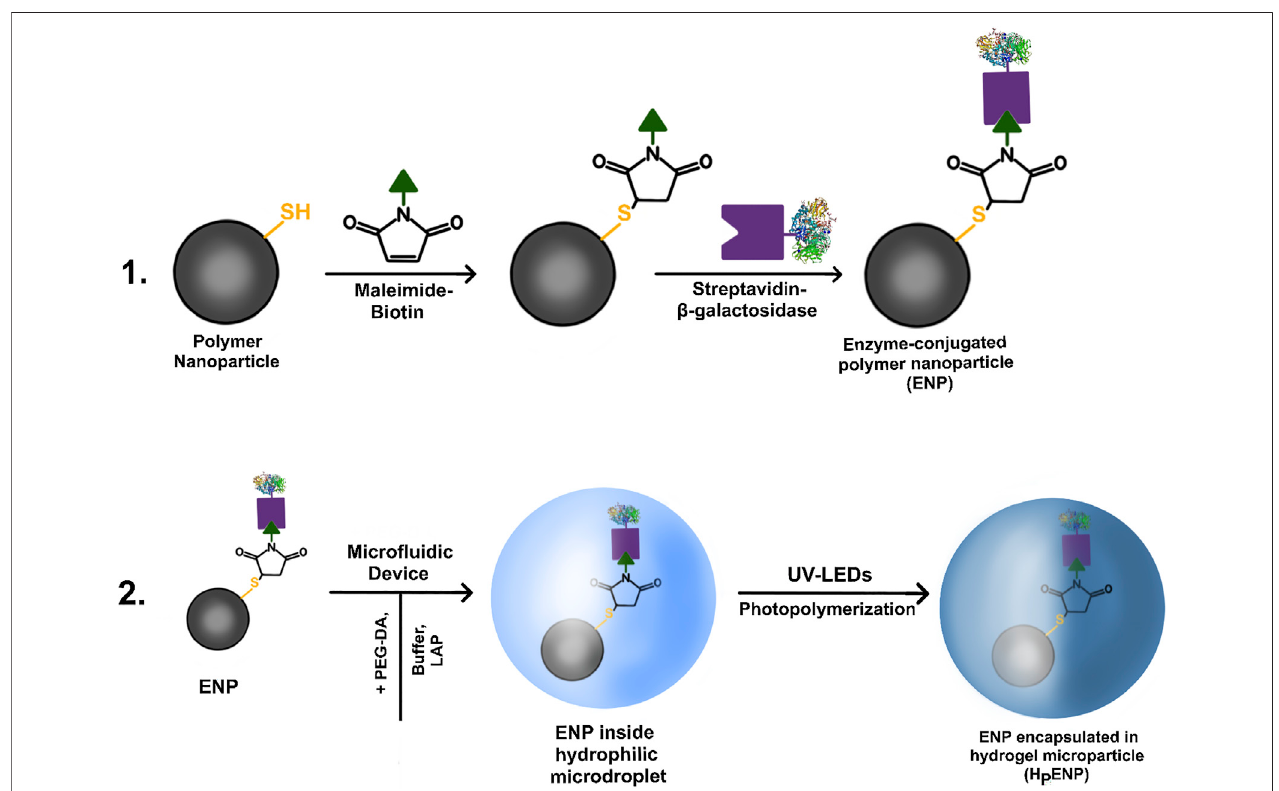
FIGURE1| Adiagramof (1) immobilizationofenzymeviatwo-stepbioconjugationprocess, (2) encapsulationofenzyme-conjugatednanoparticlesinsidehydrogel microparticles using micro fl uidic device and UV-LEDs.